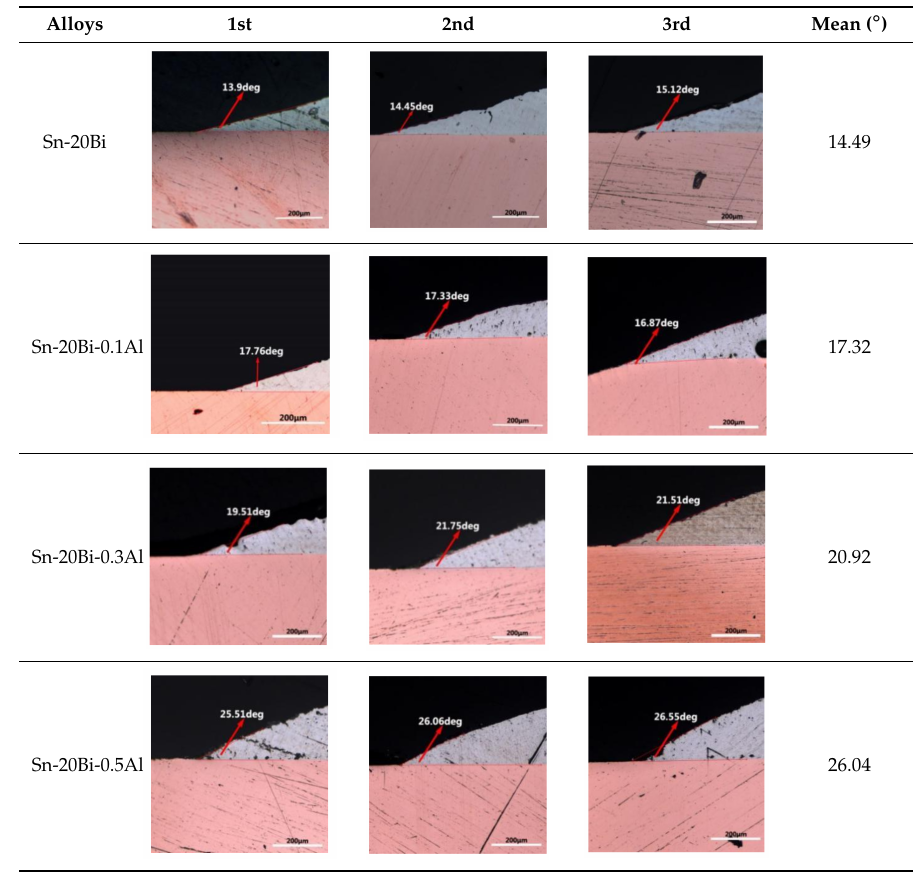
Table 1. Cross-view optical images of Sn-Bi-based solder alloys spreading on